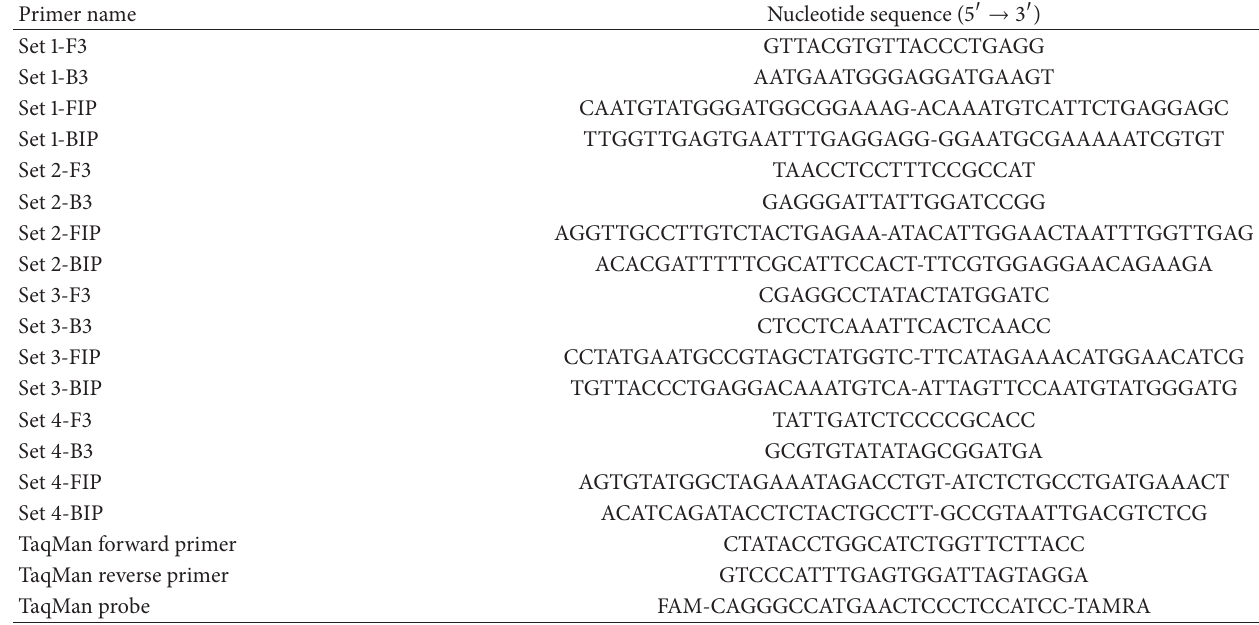
Table 1: LAMP primers used in this